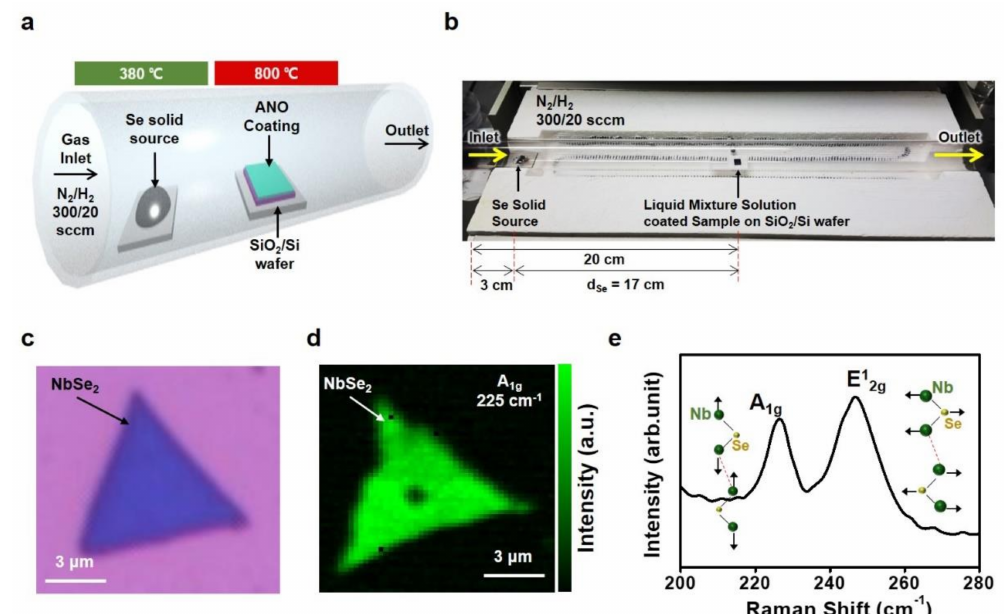
Figure 1. Synthesis settings and characteristics of chemical vapor deposition (CVD)-grown NbSe 2 : ( a , b ) The schematic image and photo image of synthesis settings for NbSe 2 Growth. The ammonium niobium oxalate-C 4 H 4 NNbO 9 · xH 2 O (ANO) source-coated substrate was loaded in the center of the CVD chamber and the solid Se was located at the upstream region where the distance is 17 cm from the center of the quartz; ( c ) optical microscope image of as-grown NbSe 2 ; ( d ) Raman mapping image according to A 1g mode; ( e ) the out-of-plane A 1g mode at 225 cm − 1 and the in-plane E 2g mode at 250 cm − 1 were